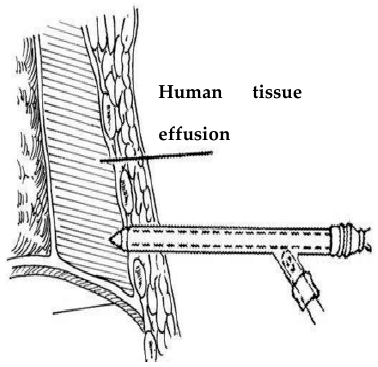
Figure 2. Diagram of thoracentesis and drainage.